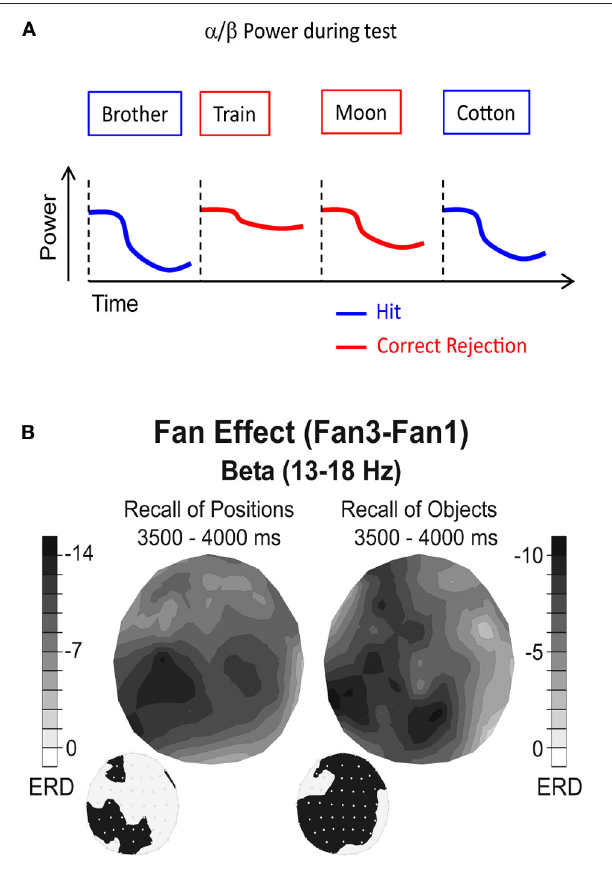
FIGURE 4 | Alpha/beta power during memory retrieval. (A) Alpha/beta power decreases are typically more pronounced during recognition of old items (hits), compared to correctly identified new items (correct rejections). (B) Beta power during retrieval of positions (left) and objects (right) is shown. Black colors denote the difference in relative power decreases (ERD) between a condition in which two items (Fan1) or four items (Fan3) were recalled. The topographies on the lower left side denote the electrode positions showing a significant difference between the two Fan conditions. Note the different topographies between recall of positions and recall of objects. Figure reproduced with permission from Khader and Rösler